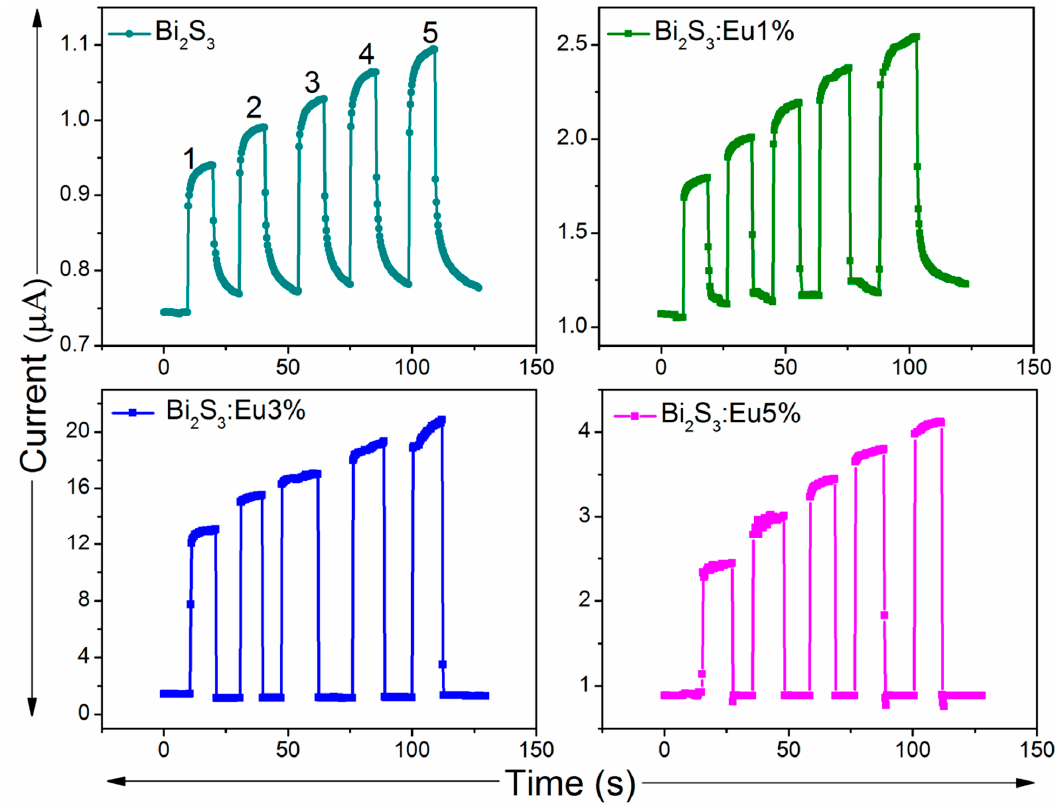
Figure 9. Plots of current vs. time of Eu-doped Bi 2 S 3 photosensor using different Eu doping concen- Figure 9. Plotsofcurrentvs. timeofEu-dopedBi 2 S 3 trations.